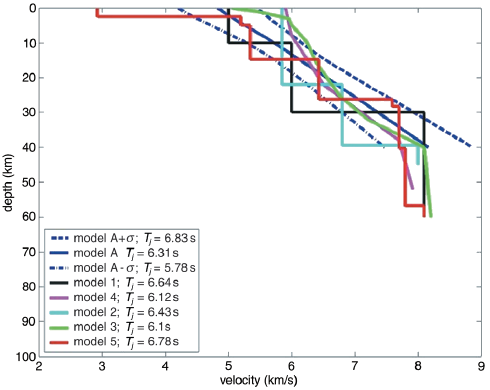
Fig. 10. The average 1D velocity model obtained from DSS/WARR data is compared to 1D models used for earthquake location